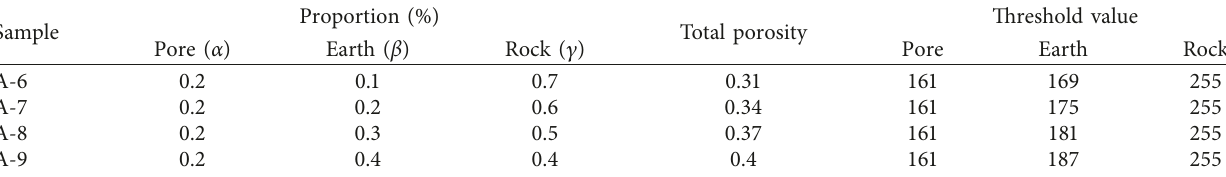
Figure 10: Permeability curve of A-1 to A-5 samples. Table 4: A-6 to A-10 sample parameters.